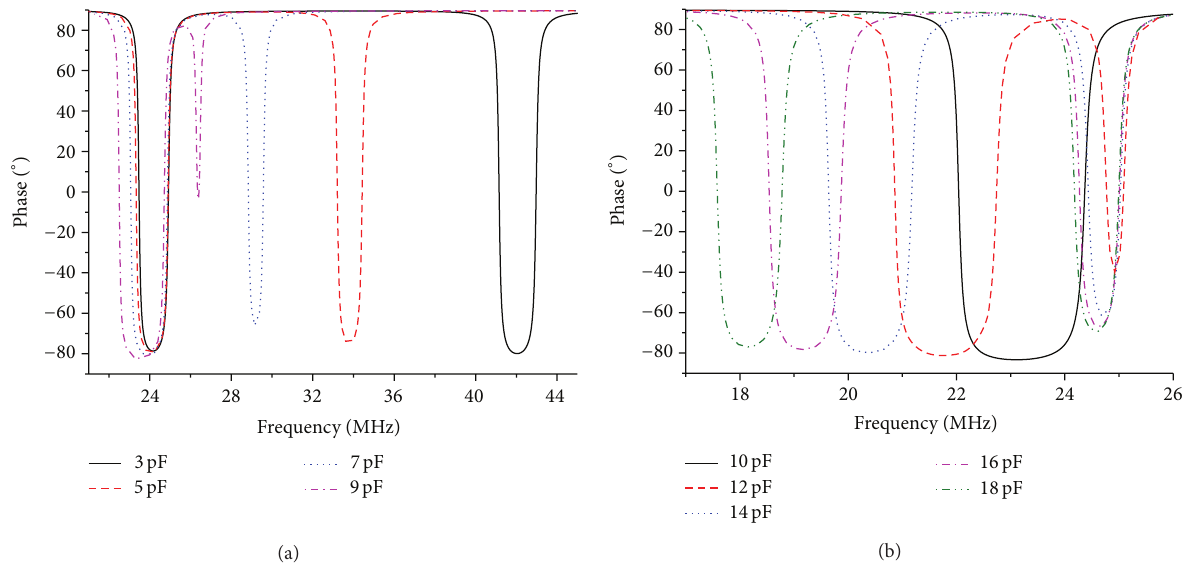
Figure 9: Test result upon changing 𝐶 1 from (a) 3 pF to 9 pF, (b) 10 pF to 18pF.